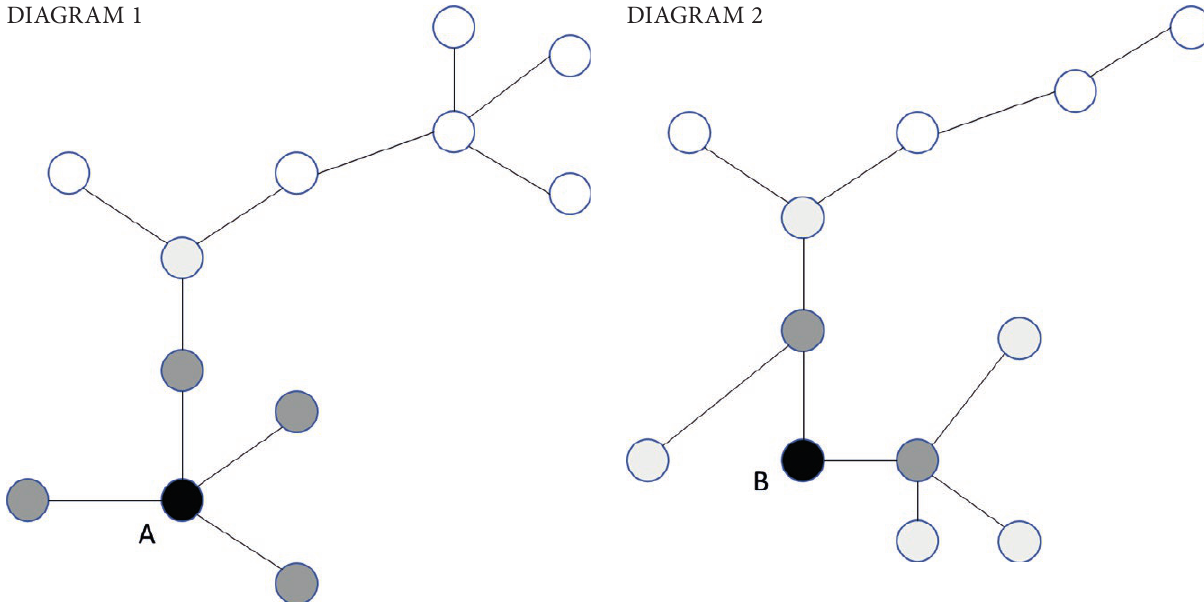
Figure 1. Th e impact of the network characteristics of the spreader on the size and time of diff usion. Source: own